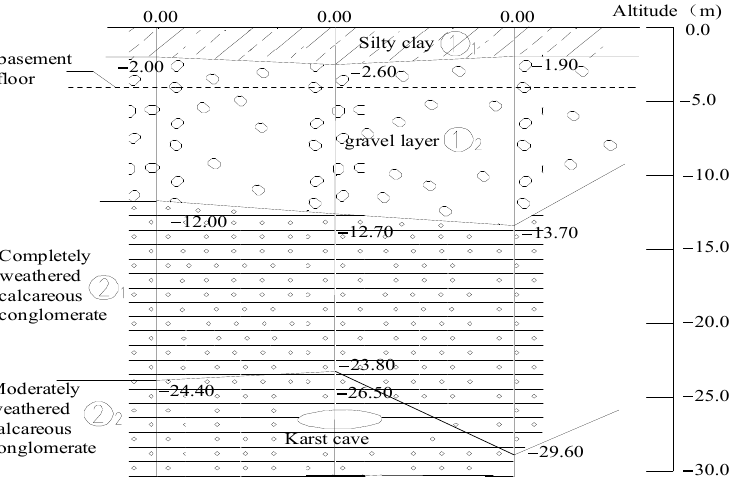
Figure 1. Unloading –r eloading stress–strain curves.